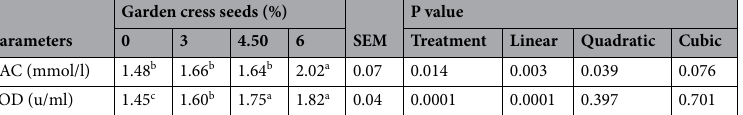
Table 6. Effect of dietary levels of garden cress seeds on serum antioxidants profile of doe rabbits. Means with different superscripts in the same row are significantly different (p < 0.05). SEM stander error means.